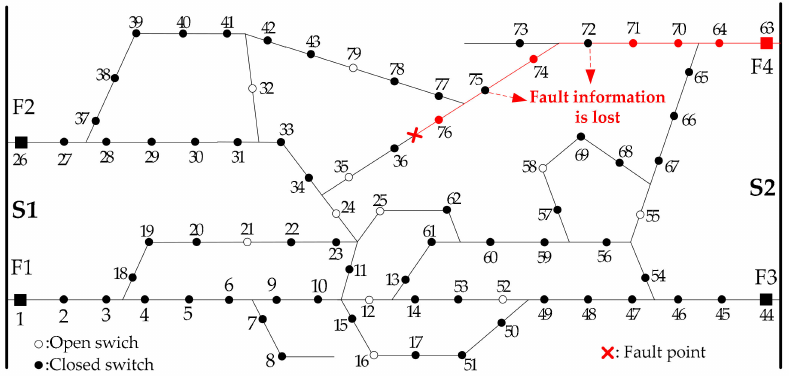
Figure 16. Fault with information